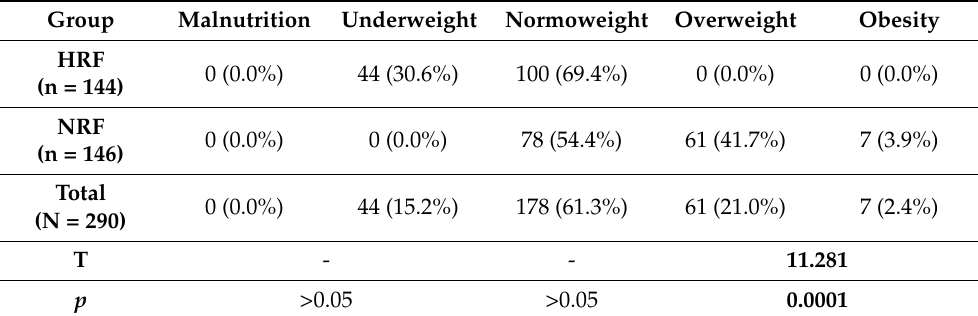
Table 1. Body mass indexes (BMI) of the students (N = 290).